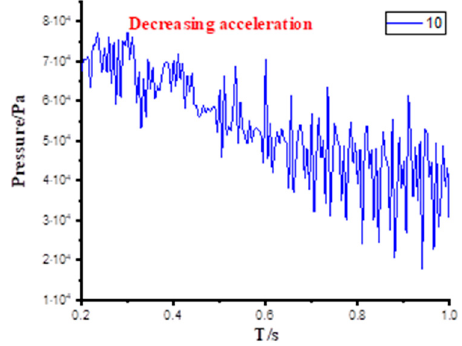
Figure 15. Cavitation pressure distribution at the bend.